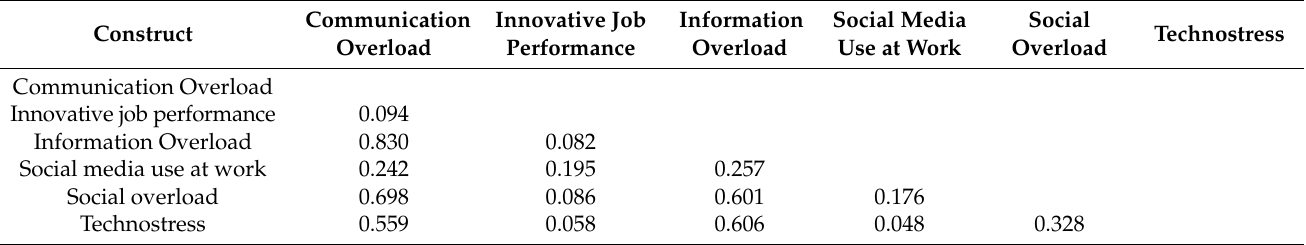
Table 6. Heterotrait–Monotrait ratio of correlations (HTMT).